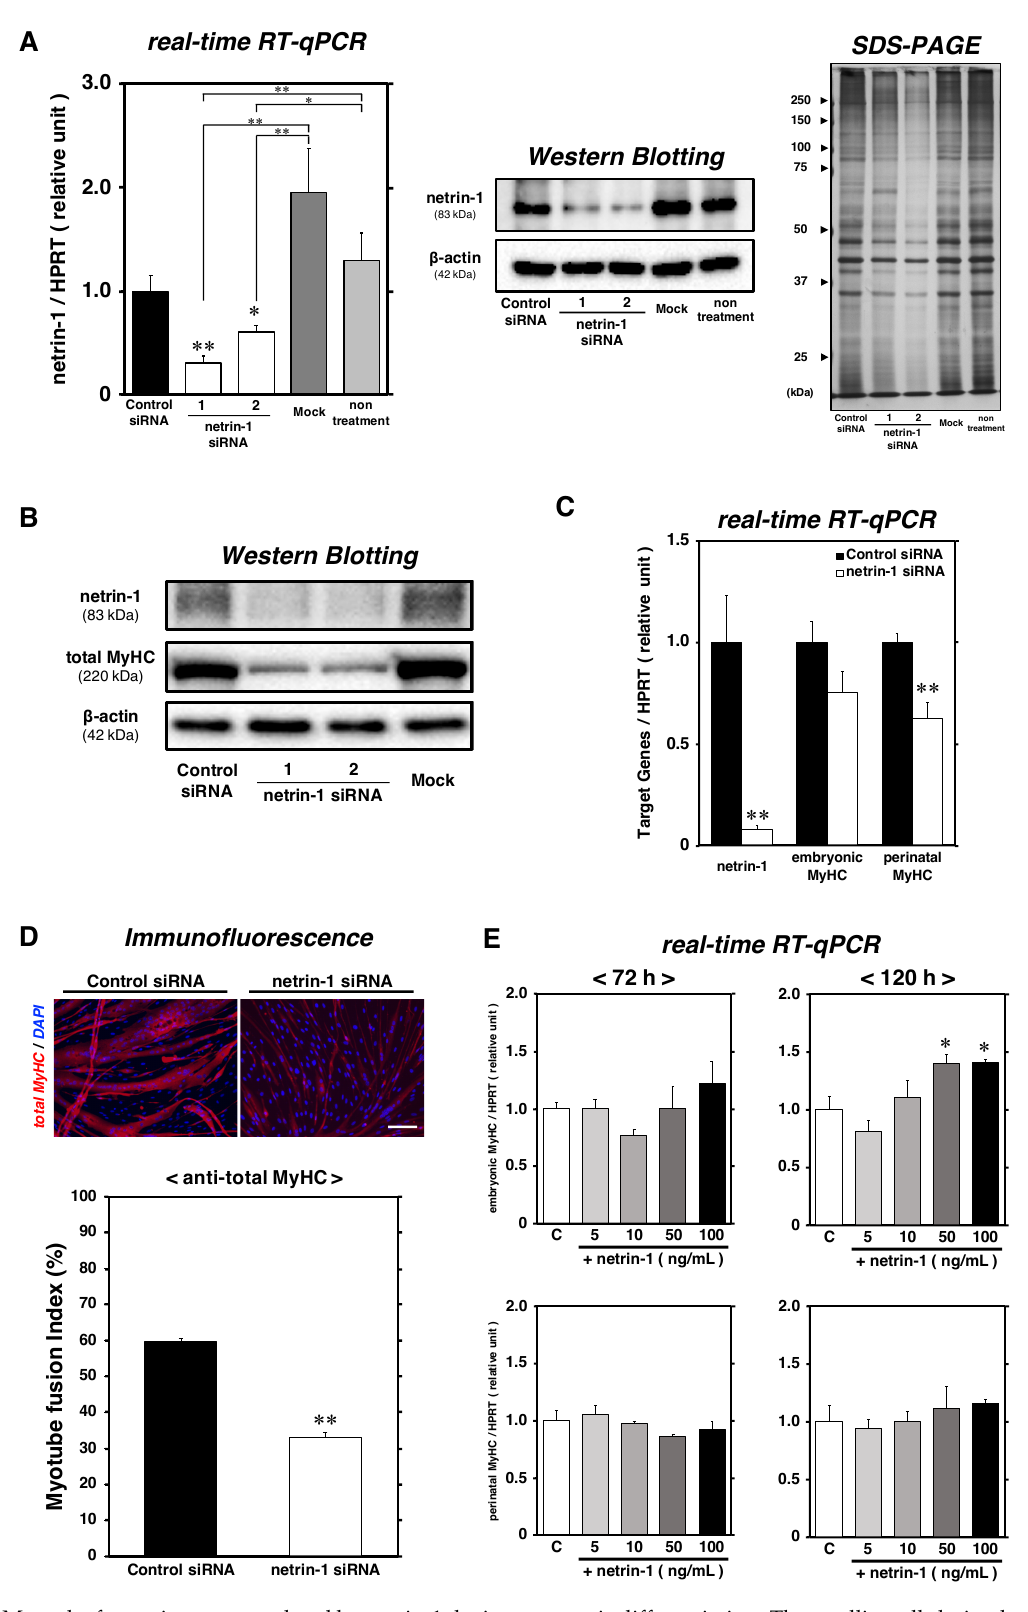
Figure 4. Myotube formation was regulated by netrin-1 during myogenic differentiation. The satellite cell-derived myoblasts were grown in the PM for 24 h, then the medium was replaced with DM, myoblasts were transfected with netrin-1 siRNAs and were incubated in the DM for up to 72 h or 120 h. (panel A – C ) The mRNA expression levels of netrin-1 at 72 h (shown in panel A ), netrin-1, embryonic MyHC, and perinatal MyHC at 120 h (shown in panel C ) were evaluated by real-time RT-qPCR and normalized to the level of HPRT. The bars depict the mean ± SEM of three independent cultures by relative units, as compared to control siRNA-treated cultures. The protein expression levels of netrin-1 at 72 h (shown in panel A